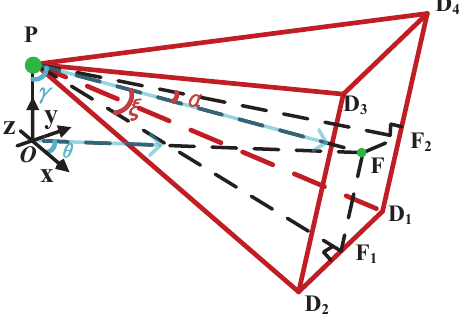
Figure 6. 3D sensing model for each camera.